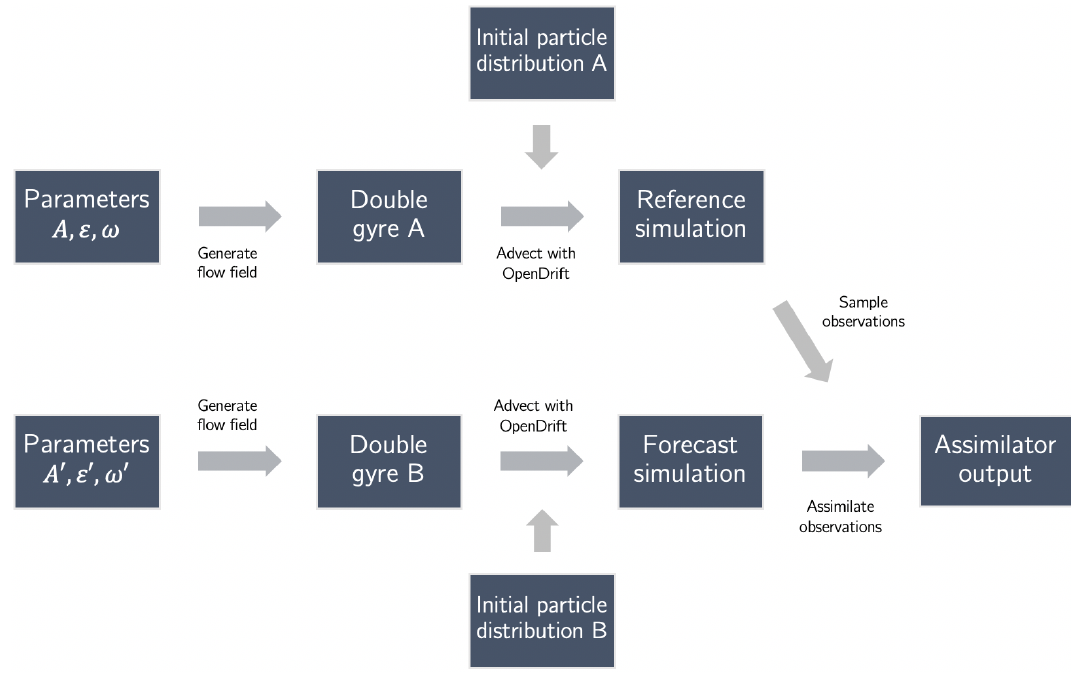
Figure 3. Schematic depiction of a test case using a reference and a forecast